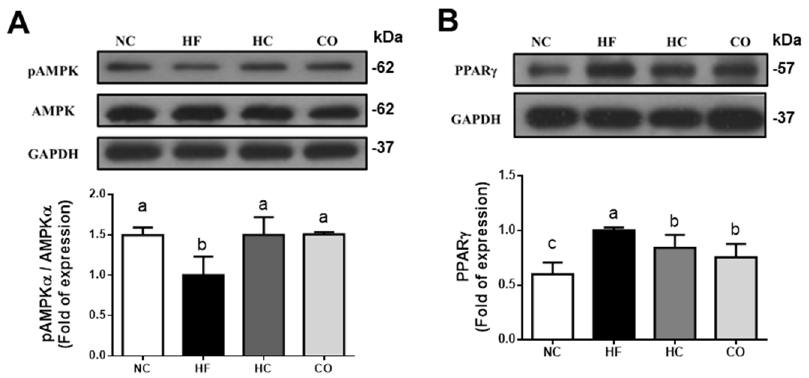
Figure 3. The changes in hepatic phosphorylated AMPK α . AMPK α ( A ), and PPAR- γ ( B ) protein expression in rats fed with different experimental diets for 12 weeks. Protein expression for pAMPK α , AMPK α , and PPAR- γ was determined by Western blotting. Densitometric analysis for protein levels corrected to each internal control was shown. Data are expressed as the mean ± S.D. for each group ( n = 4–5). Values with different superscript letters (a, b, c) are significantly different from each other ( p < 0.05). NC: Normal control diet (chow diet). HF: High-fat diet (chow diet + 10% lard). HC: HF diet + 5% high-molecular-weight chitosan. CO: HF diet + 5% chitosan oligosaccharides.